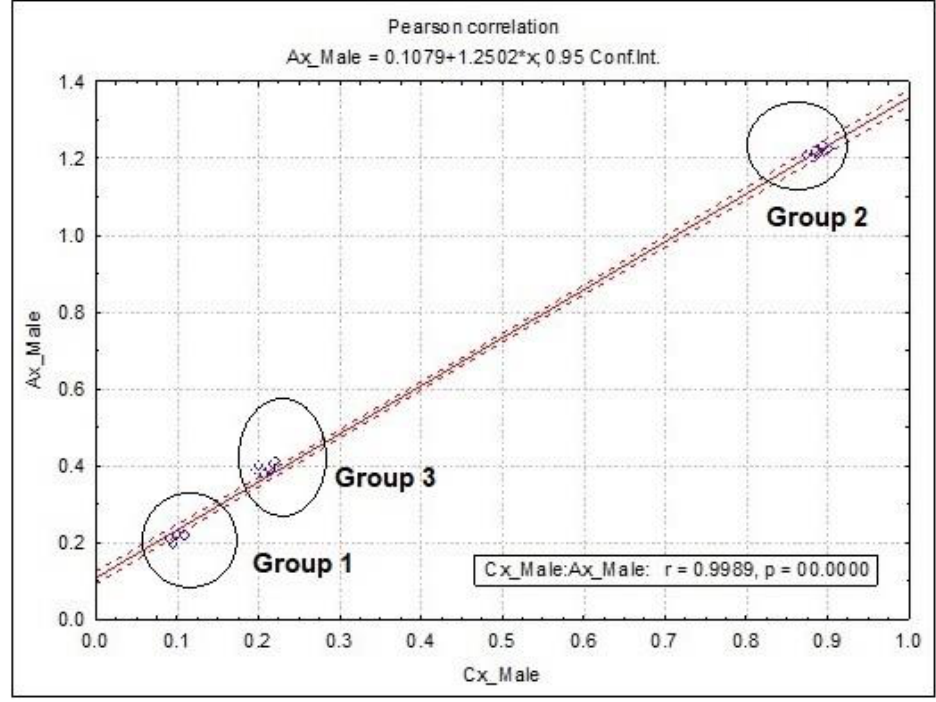
Figure 6. Pearson correlation between Ax and Cx accumulation in the male gonads of rainbow trout, O. mykiss .